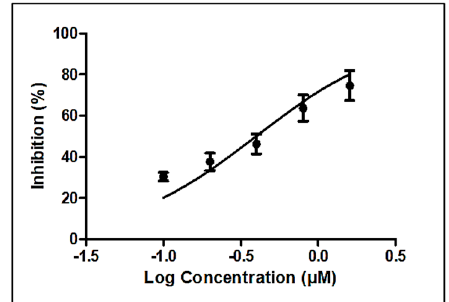
Figure 4. Estimation of nematicidal IC 50 of linoleic acid (Sigma, St. Louis, MO, USA).